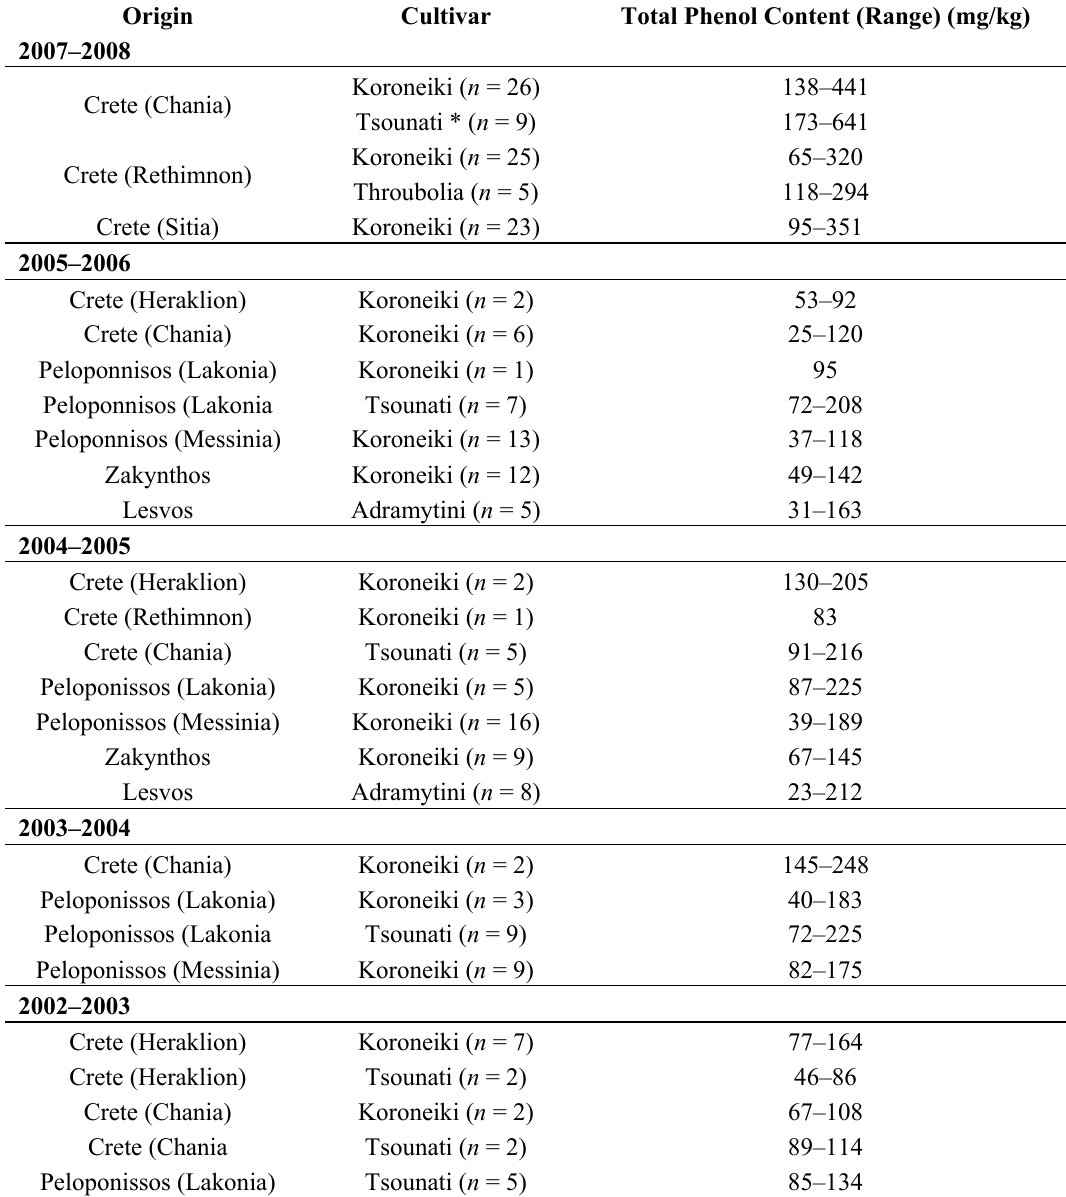
Table 1. TPC reported for Greek virgin olive oils, determined by 1 H and 31 P-NMR